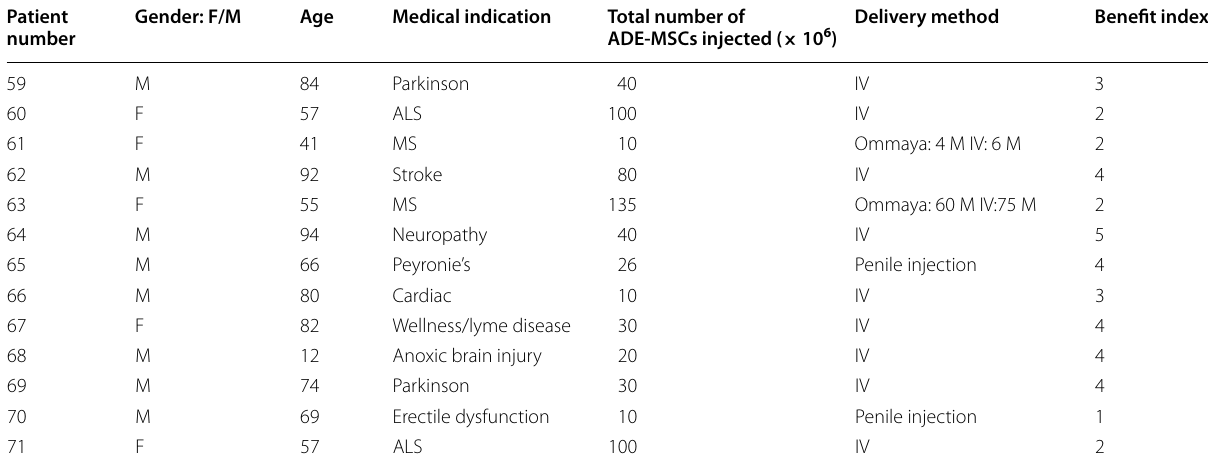
Table 3 List of 13 ADE-MSCs-treated patient’s gender, age, medical indication, delivery methods and benefit index Patient